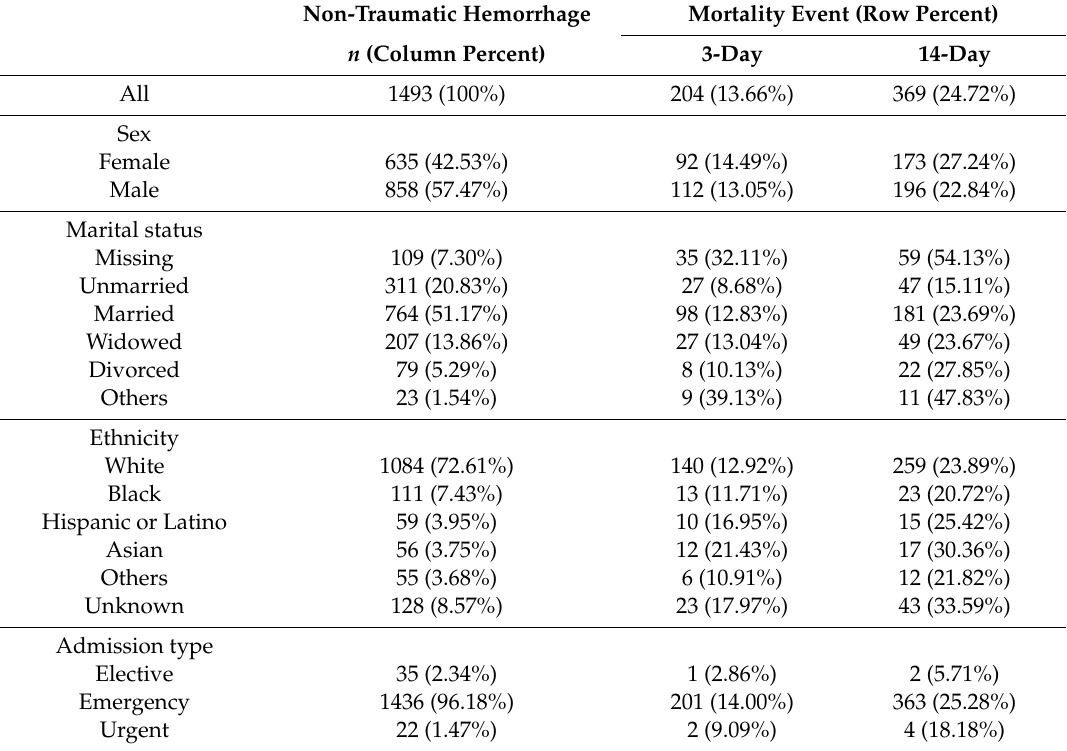
Table 1. Demographic characteristics of patients with non-traumatic intracranial